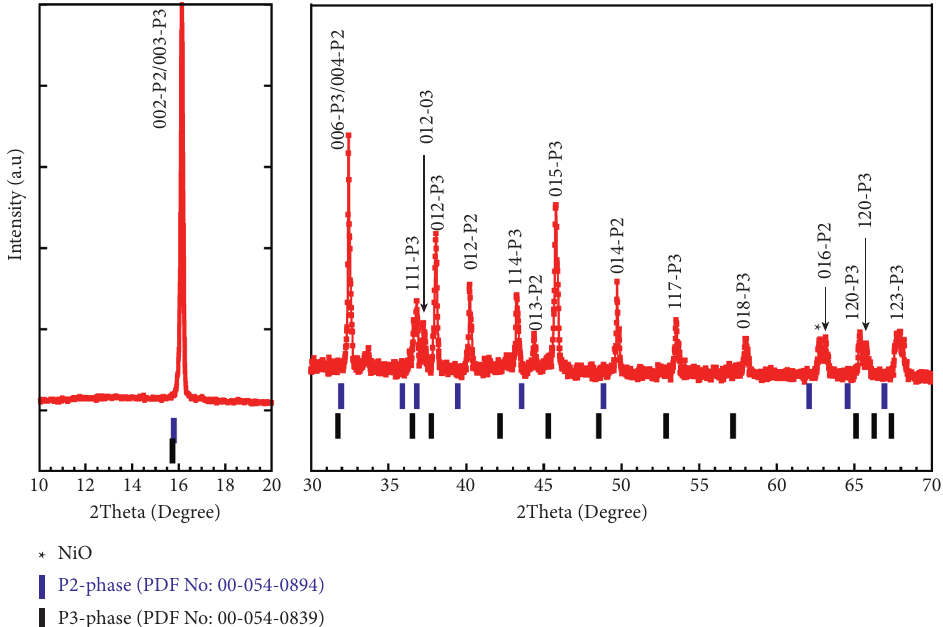
Figure 1: X-ray diffraction pattern of the synthesized NaNMC.